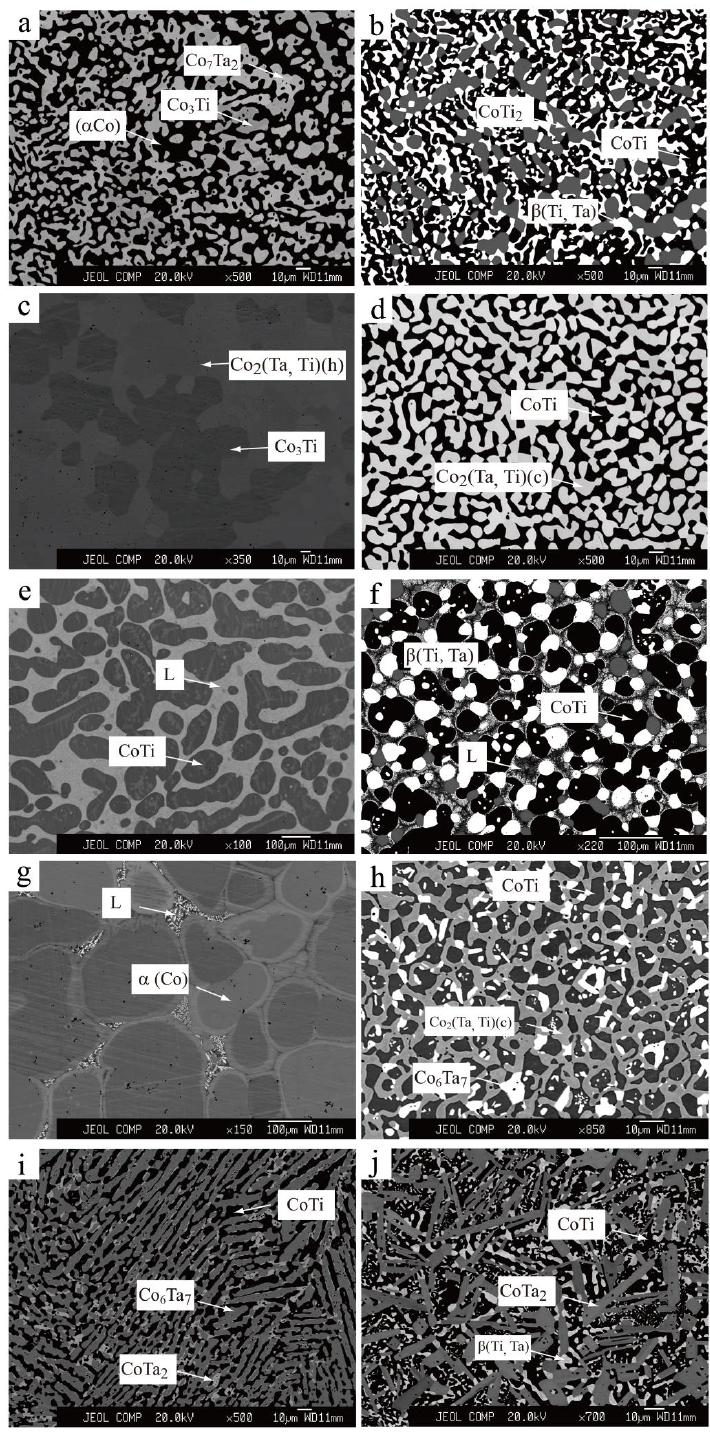
Figure 2. Typical ternary BSE (Back scattered Electron) images obtained from: ( a ) Co 80 Ti 9 Ta 11 alloy annealed at 1000 ◦ C for 45 days; ( b ) Co 30 Ti 50 Ta 20 alloy annealed at 1000 ◦ C for 45 days; ( c ) Co 71 Ti 28 Ta 1 alloy annealed at 1000 ◦ C for 45 days; ( d ) Co 60 Ti 30 Ta 10 alloy annealed at 1100 ◦ C for 35 days; ( e ) Co 40 Ti 58 Ta 2 alloy annealed at 1100 ◦ C for 8 h; ( f ) Co 30 Ti 50 Ta 20 alloy annealed at 1100 ◦ C for 8 h; ( g ) Co 85 Ti 13 Ta 2 alloy annealed at 1200 ◦ C for 25 days; ( h ) Co 55 Ti 15 Ta 30 alloy annealed at 1200 ◦ C for 25 days; ( i ) Co 45 Ti 15 Ta 40 alloy annealed at 1200 ◦ C for 25 days; and ( j ) Co 30 Ti 20 Ta 50 alloy annealed at 1200 ◦ C for 25